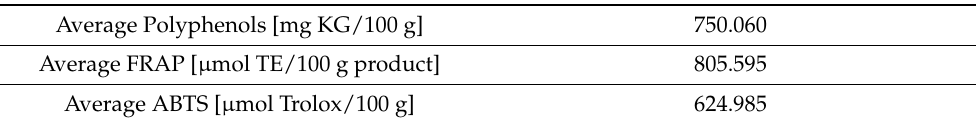
Table 10. Total polyphenol content and antioxidant activity of convection-dried apple pomace at 60 ◦ C tested by ABTS and FRAP